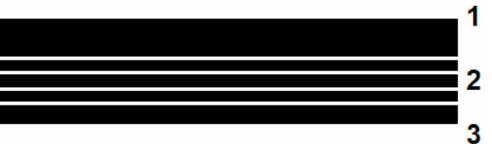
Figure 1. The composition of the tested conveyor belt: (1) top cover layer; (2) carcass—polyamide’s plies; and (3) bottom cover layer.